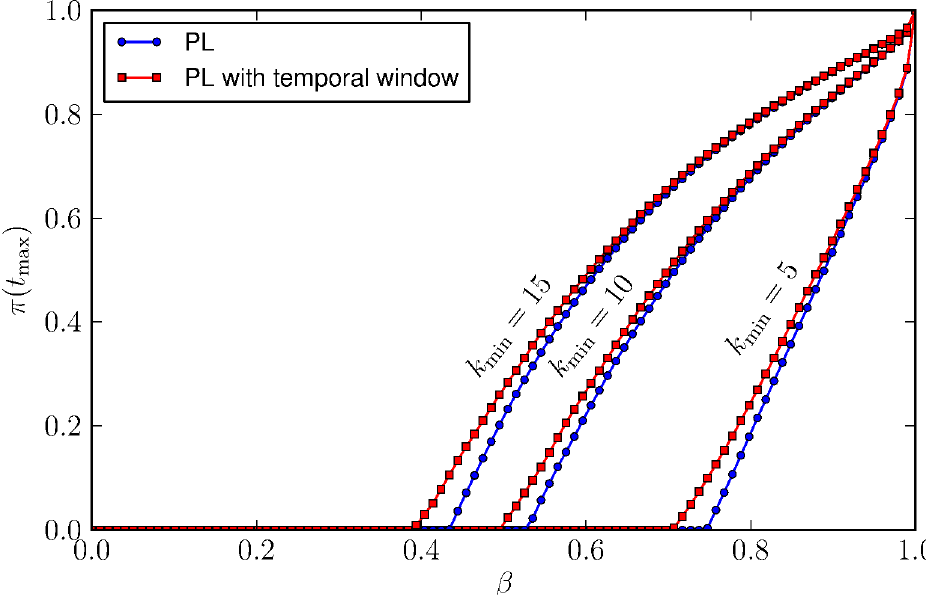
Figure 8. Median of the final prevalence as a function of the transmission probability. A PL distribution of vectors-per-host has been considered in all scenarios. Simulations that consider different aggregation behaviours according to the temporal window of mice abundance (red) are compared with others with a fixed distribution (blue). Other parameters are N h ~ 10 4 , t max ~ 10 3 , and f ~ 10% .